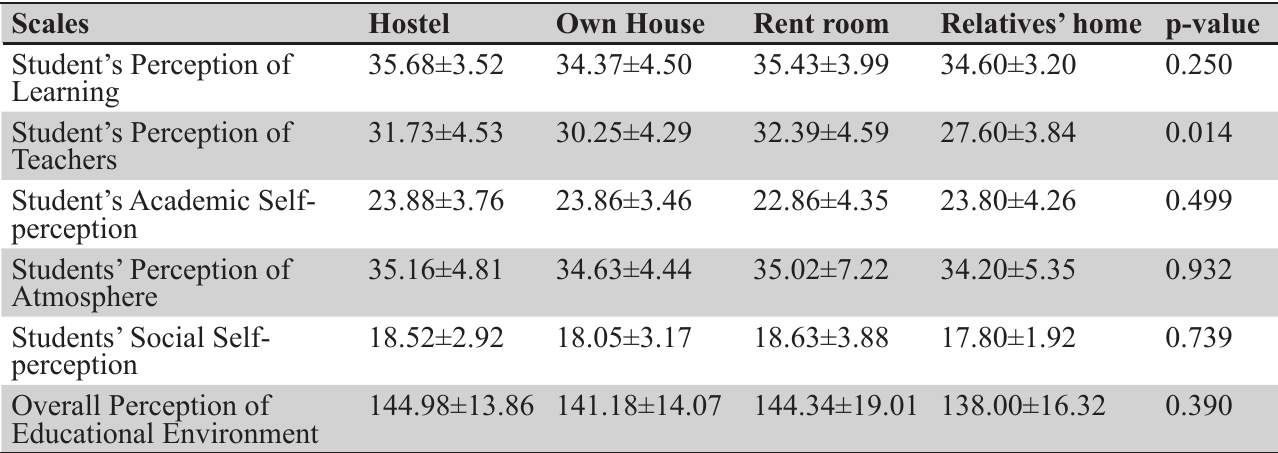
Table 4. Association of Perception of Educational Environment and its subscales with Nature of Accommodation of